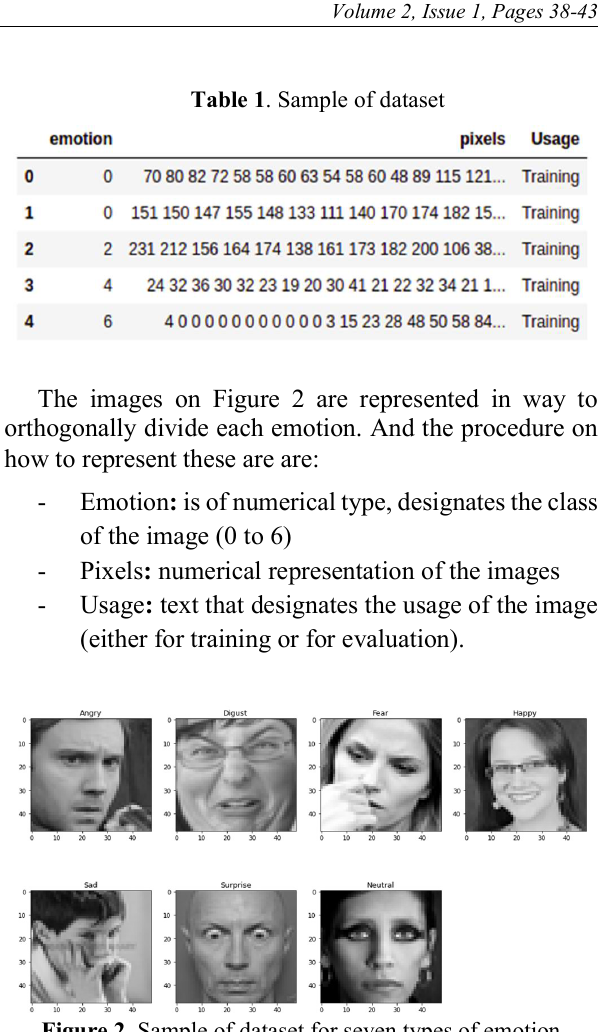
Figure 1 . Model of Robert Plutchik [5]